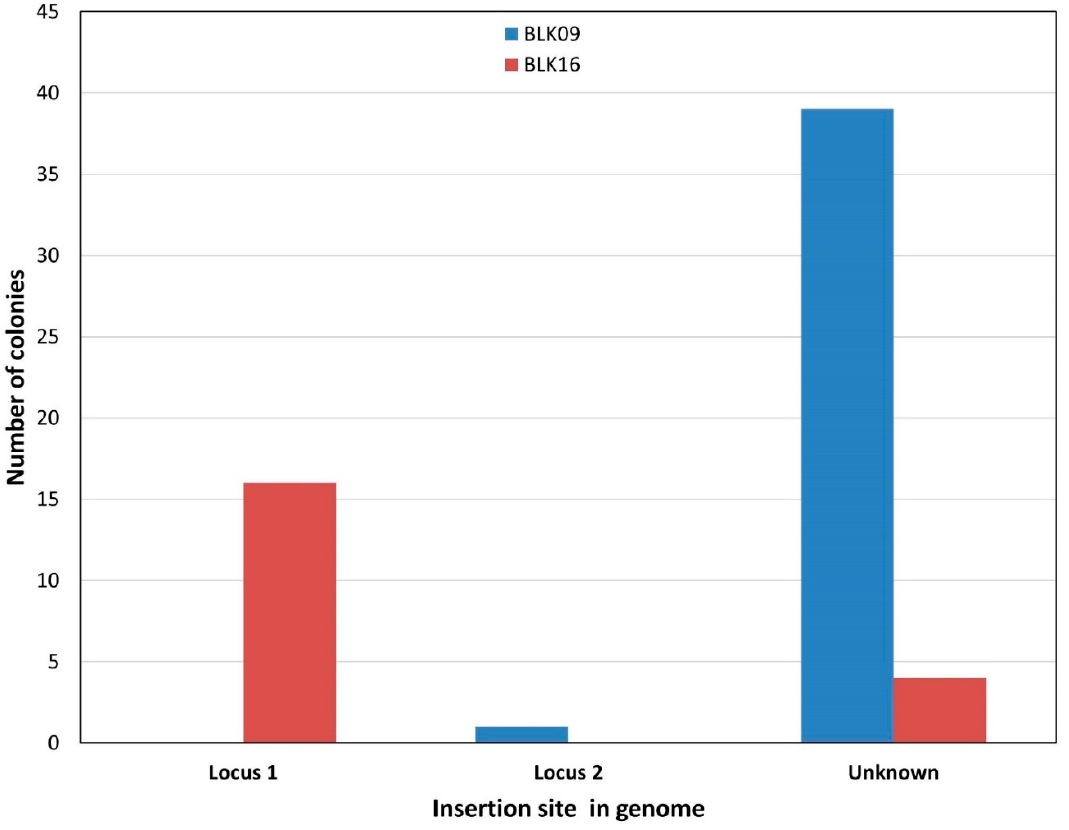
Figure 5. Integration of vioABCDE _KmR cassettes into chromosomal IS 3 elements using recombineering followed by pCas9IS3-mediated counterselection. The number of colonies harboring a PCR-verified integration at locus 1, locus 2, or displaying no PCR-verified integration (“unknown”) are shown for E. coli BLK09 (blue) and E. coli BLK16 (red). The yields of recombinants were 4 and 30 recombinants/ng DNA for BLK09 and BLK16, respectively. An exemplary experimental outcome is displayed from a set of four similar experiments (two for each strain).